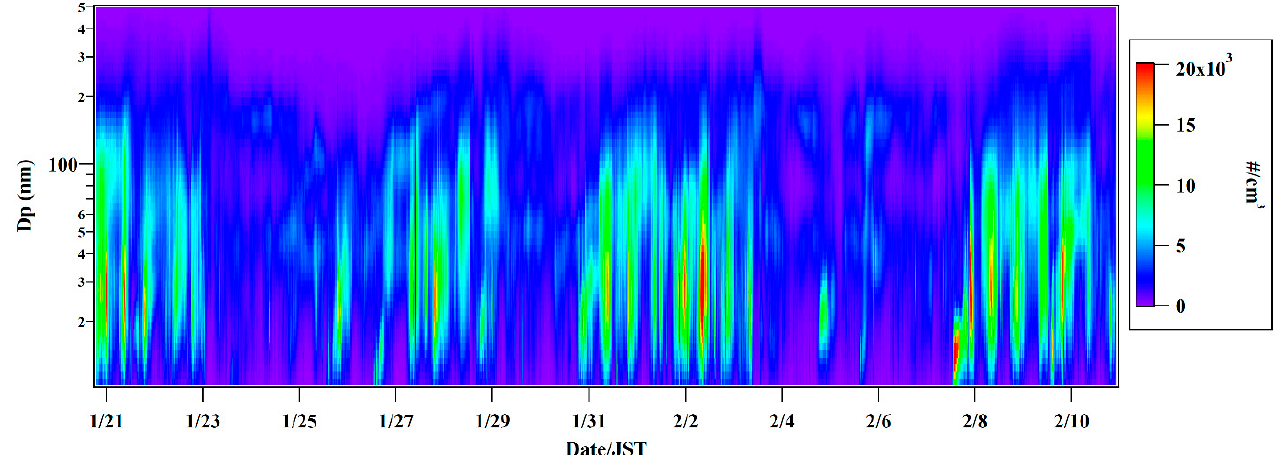
Figure 3. Particle number concentration.